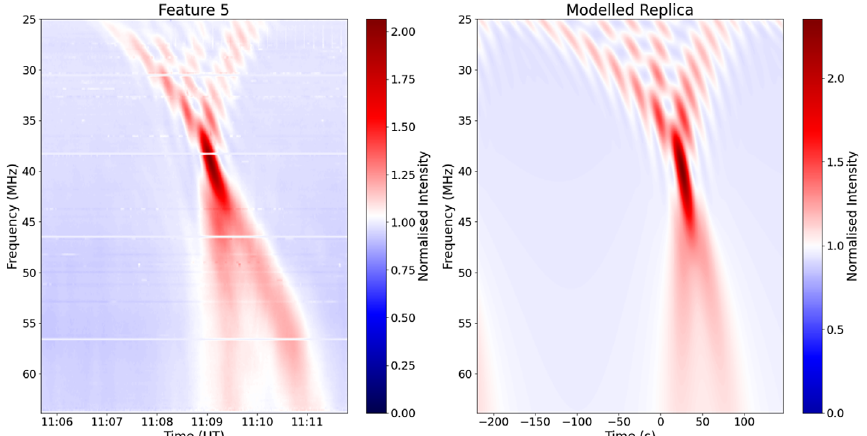
Fig. 9. Feature 5 and its modelled replica. Again the time scale of the model and observation are the same, but the intensity scales used are different. The parameters used here are: U 0 = 3.5 (cid:2) 10 8 rad Hz, K = 15 km, h = 8.4 (cid:3) , a = 7.37 (cid:2) 10 5 rad Hz m (cid:3) 1 and A = (cid:3)